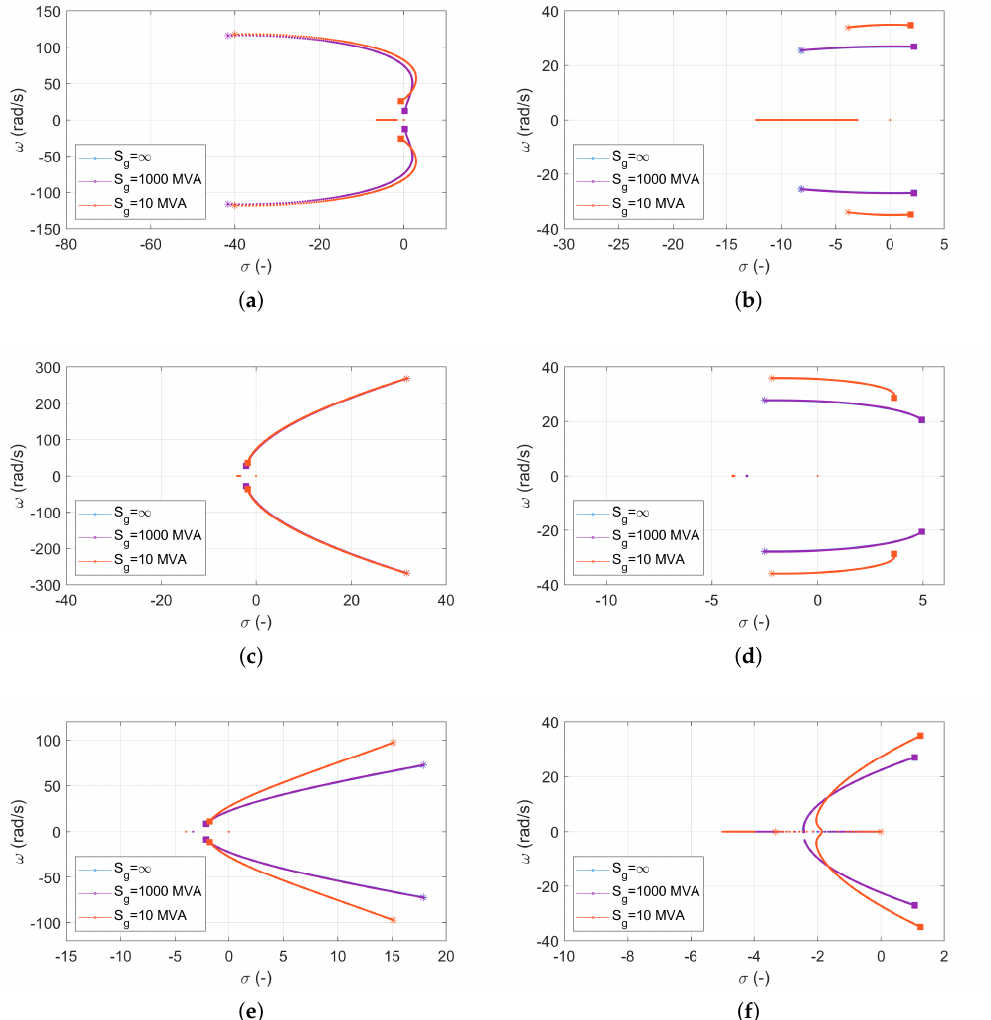
Figure 5. Plot of system eigenvalues for different parametric sweeps: starting from stars, ending to squares. ( a ) Inertia H c (0.01–10 s); ( b ) Droop R c (0.01–0.1 pu); ( c ) Converter rated power S c (0.1–10 MVA); ( d ) Measurement time constant T pf (0–0.05 s); ( e ) Impedance magnitude (0.1–10 pu); ( f ) Impedance angle (0–90